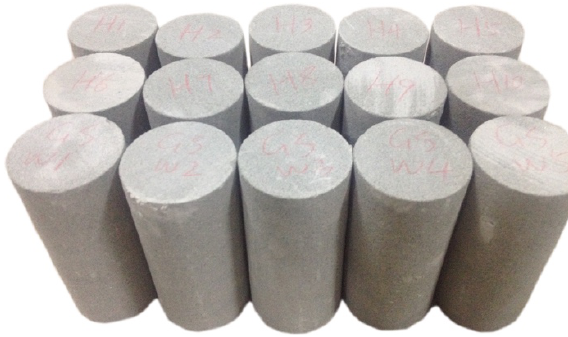
Figure 1. Sandstone specimens without distinct layering or lamination observed.